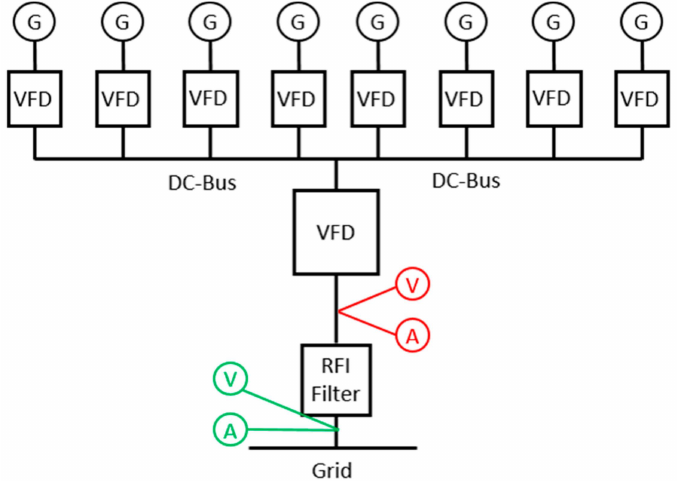
Figure 3. Mutriku wave power plant single line drawing showing how the eight generators were connected to the grid via a single DC-bus and the ideal and actual placement of the